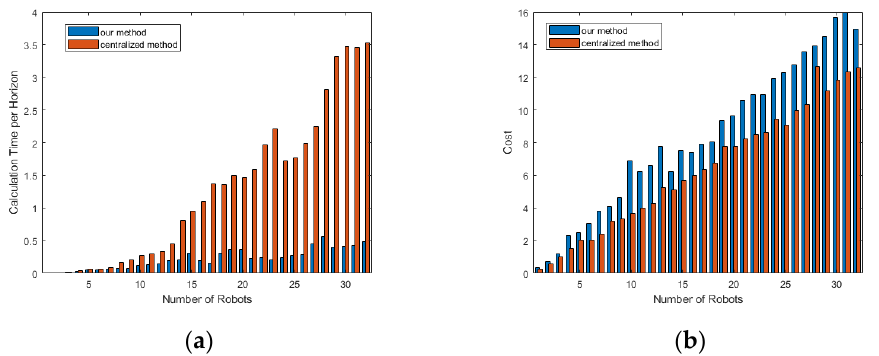
Figure 11. Comparison between our method and centralized method. ( a ) calculation time per horizon, ( b ) cost.